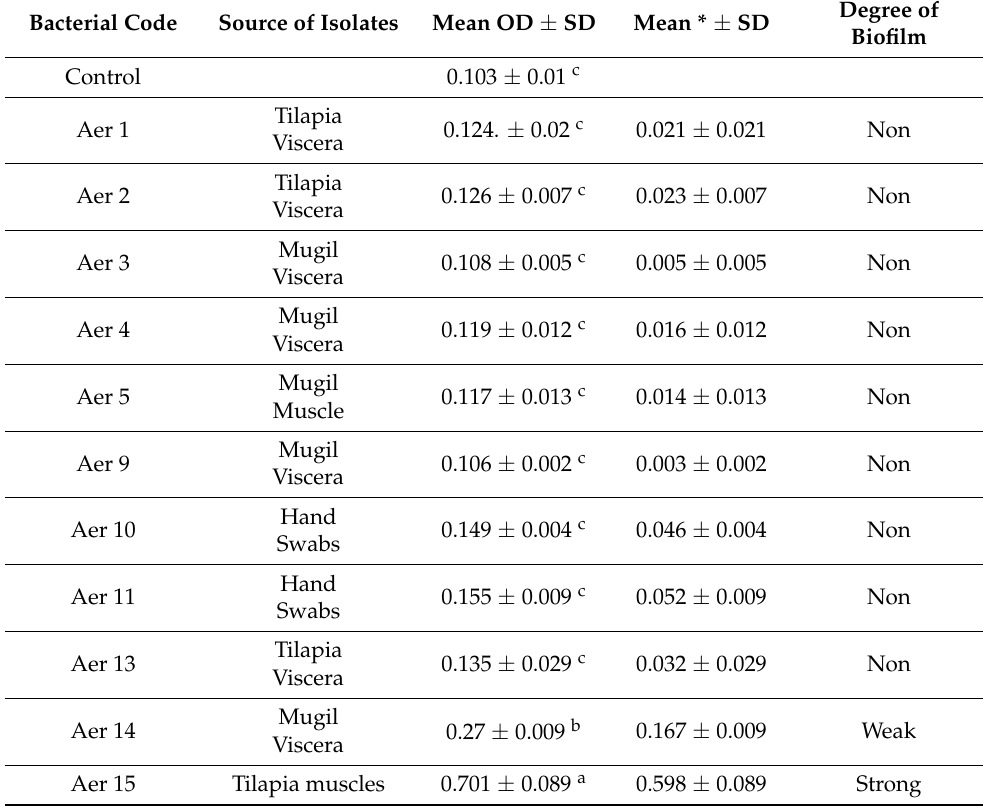
Table 6. Biofilm production by Aeromonas spp. using microtiter plate